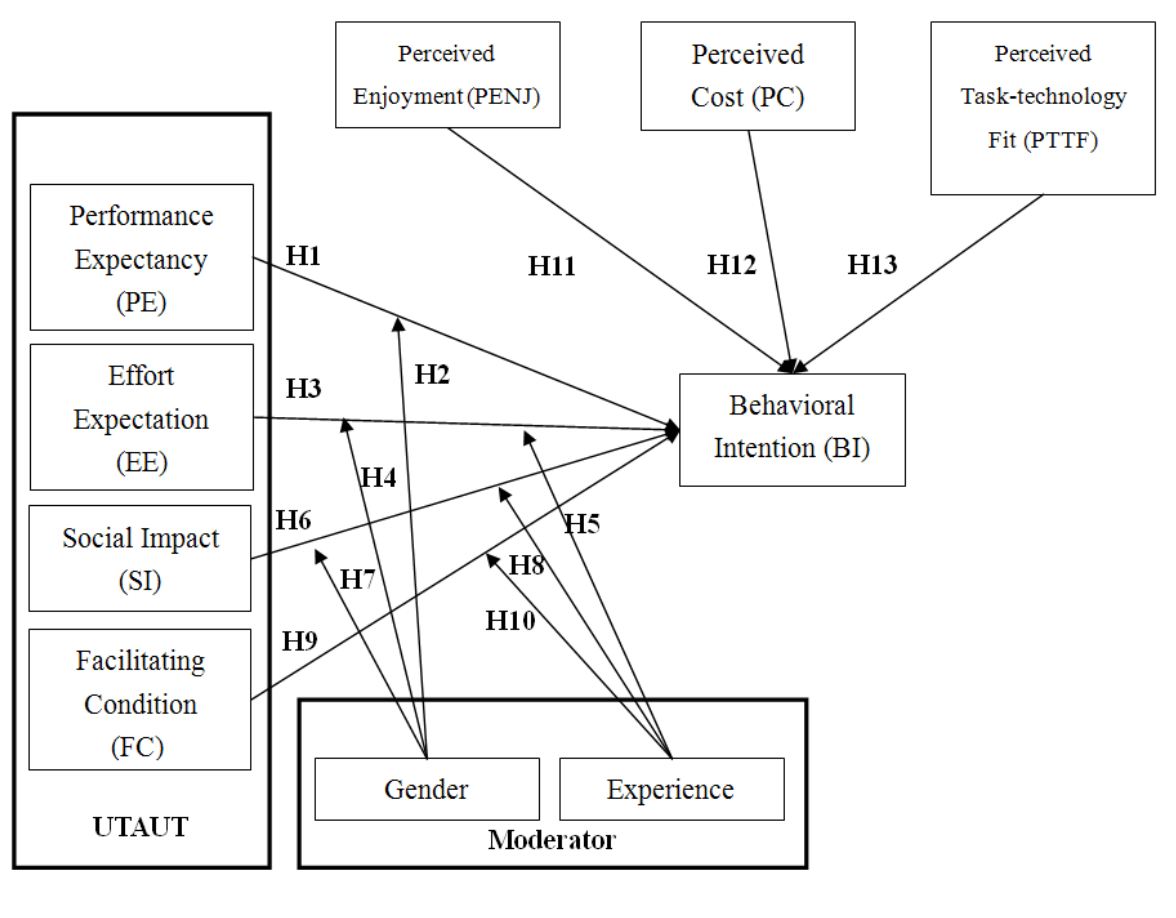
Figure 1. The research